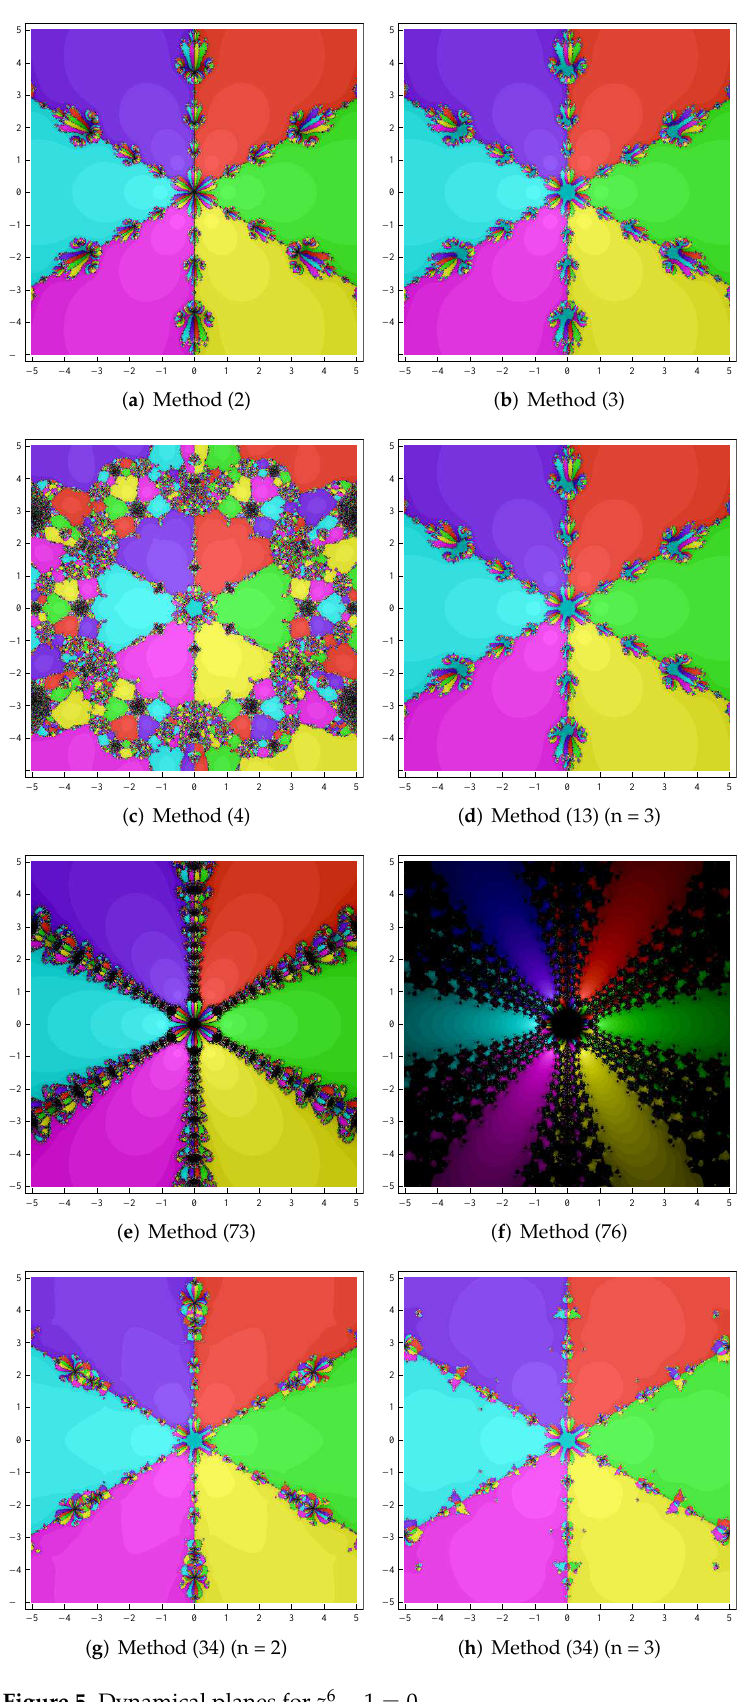
Figure 5. Dynamical planes for z 6 − 1 =